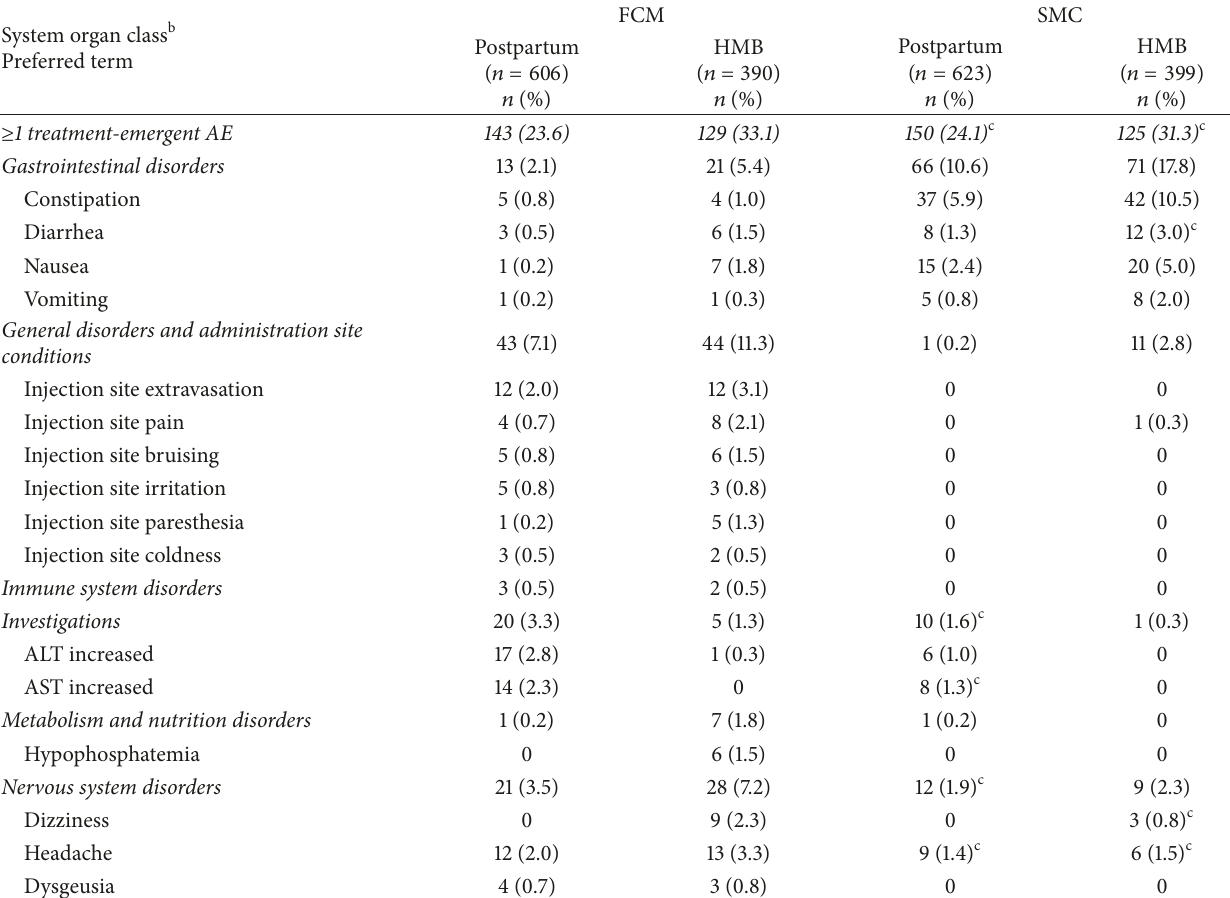
Table 4: Treatment-emergent adverse events occurring in ≥ 2% of subjects in either treatment group or with a statistically significant difference a between the FCM or SMC treatment groups by anemia etiology (safety population).